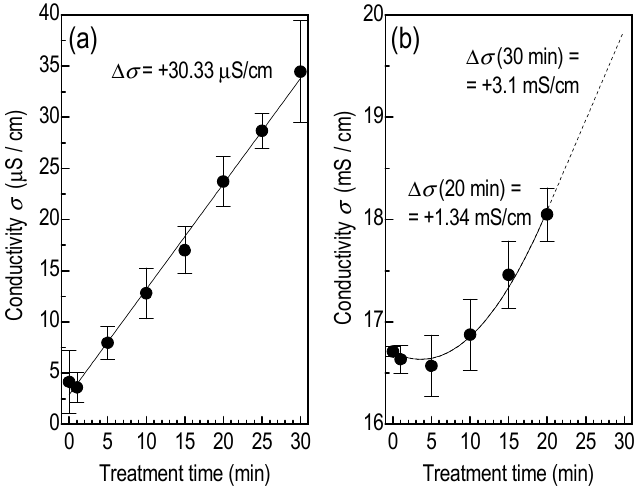
Figure 12. Conductivity evolution versus the treatment time in the case of ( a ) DDW and ( b ) PBS (see text for discussion on the extrapolation curve between 20 and 30 min). Mean values and standard deviations are calculated from two series of experiments carried out on different dates. Operating